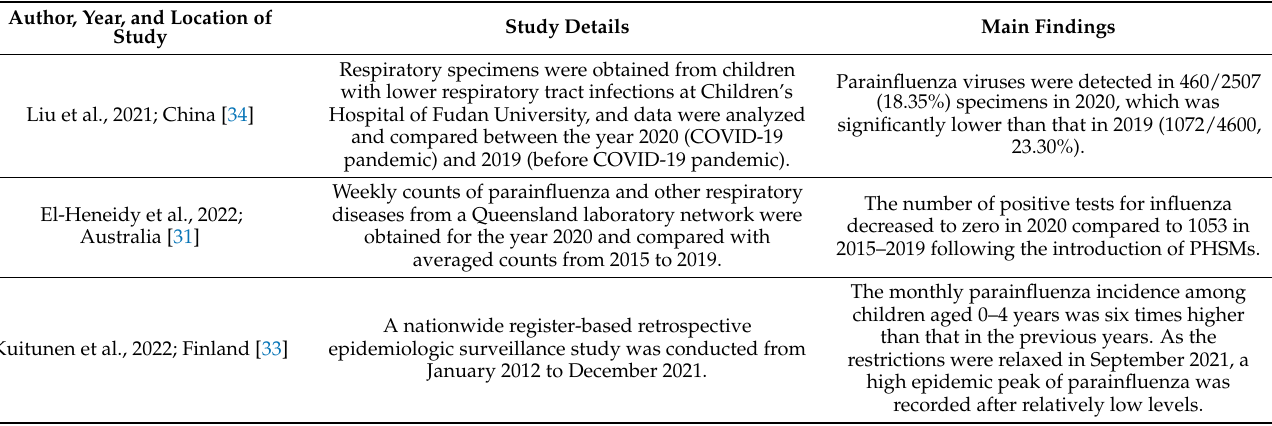
Table 2. Summary of parainfluenza-related articles included in the systematic literature